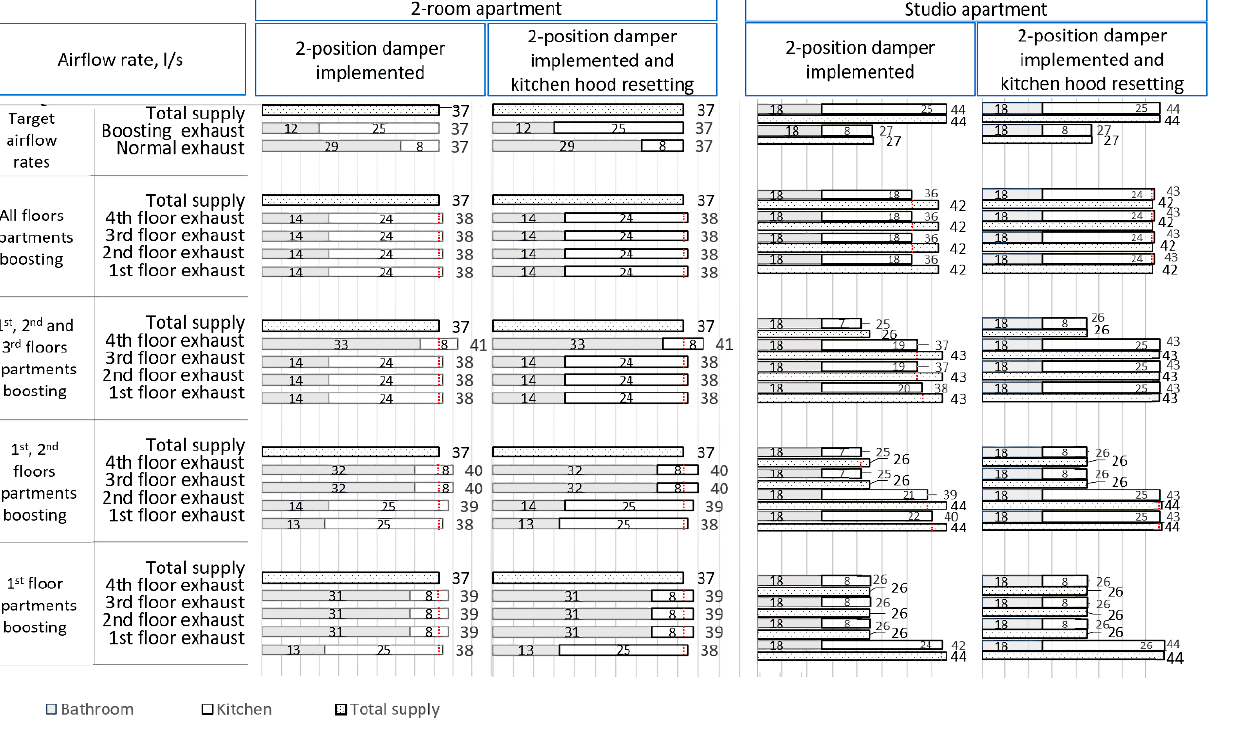
Figure 7. Airflow rates of the 2-room and studio apartments in boosting and normal modes with two position dampers installed and with two positions dampers and an improved balancing method.